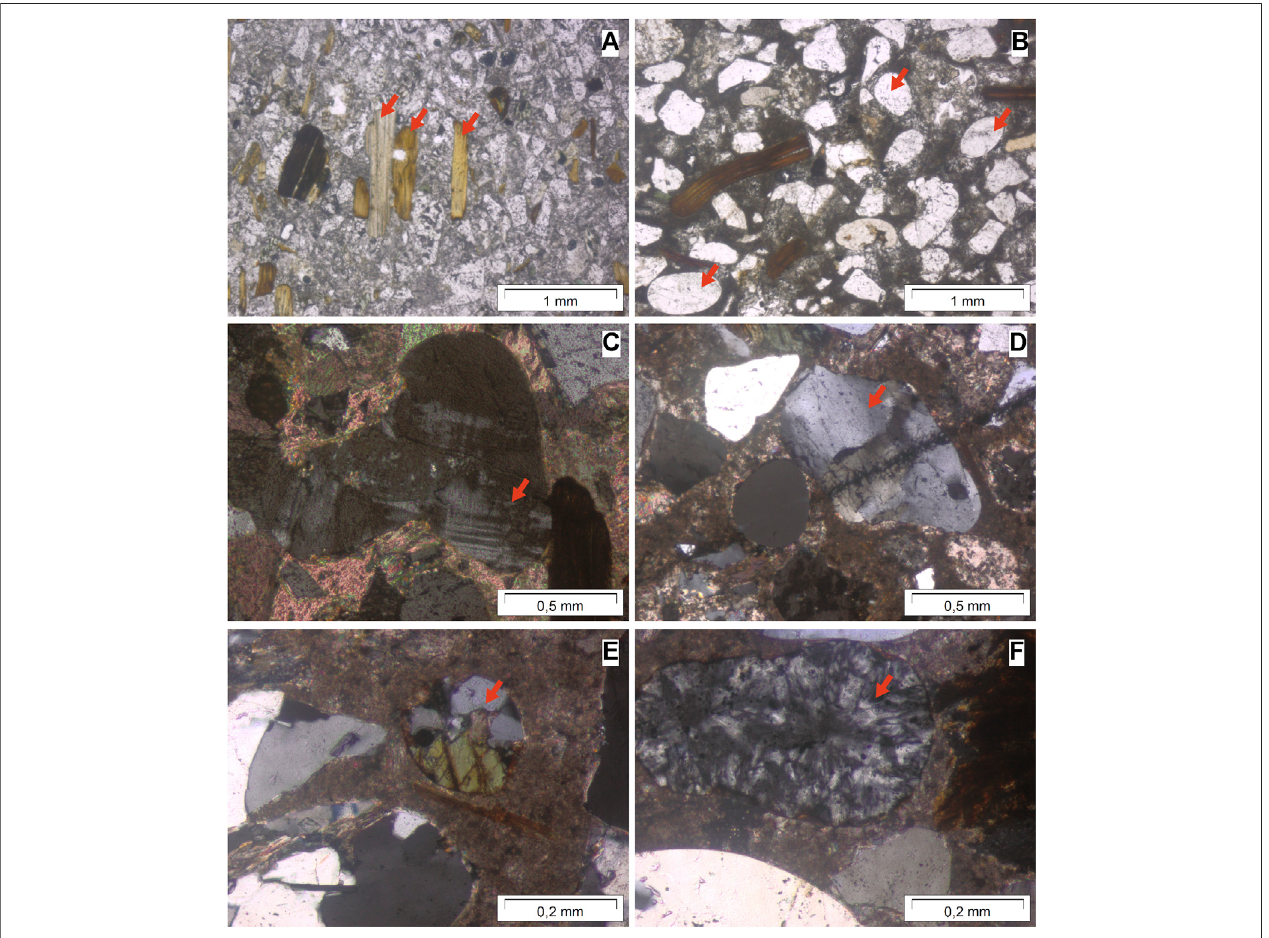
FIGURE6| Thinsectionsmicrophotographs[under polarizingmicroscope, (A,B) parallelpolars, (C – F) crossedpolars]showing(redarrows): (A) elongated biotite; (B) rounded to subrounded quartz; (C) rounded K-feldspar; (D) subrounded plagioclase; (E) a lithic grain of amphibolite (quartz + amphibole); (F) rounded chalcedony.